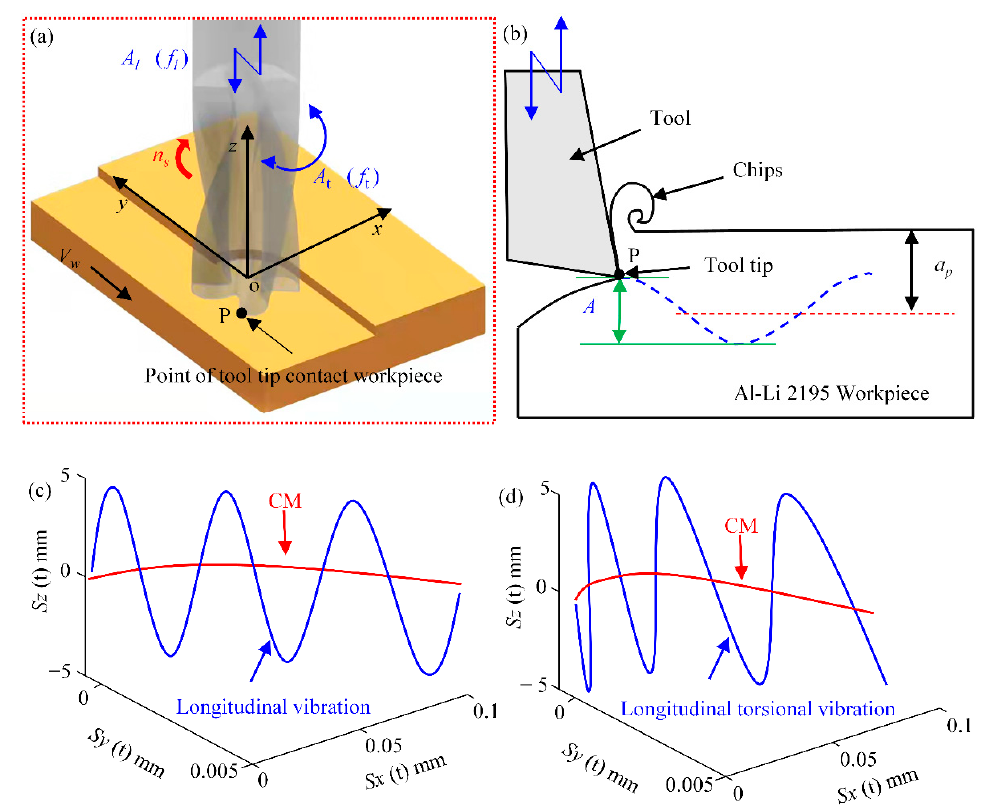
Figure 2. Schematic diagram of the variation lever and tool ( a ) Tool trajectory analysis; ( b ) Principle of Ultrasonic Vibration Milling; ( c ) Longitudinal ultrasonic vibration tool tip motion trajectory; ( d ) Longitudinal-torsional ultrasonic vibration tool tip motion trajectory .